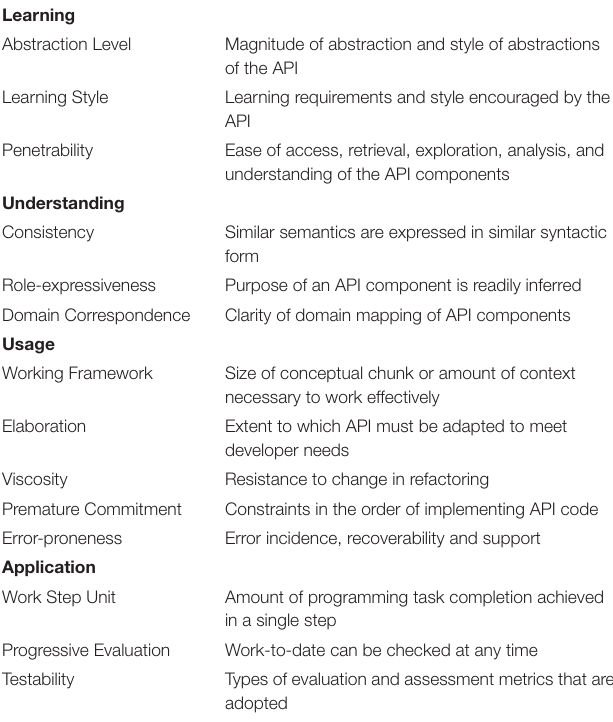
TABLE 2 | The adapted Cognitive Dimensions framework used in our